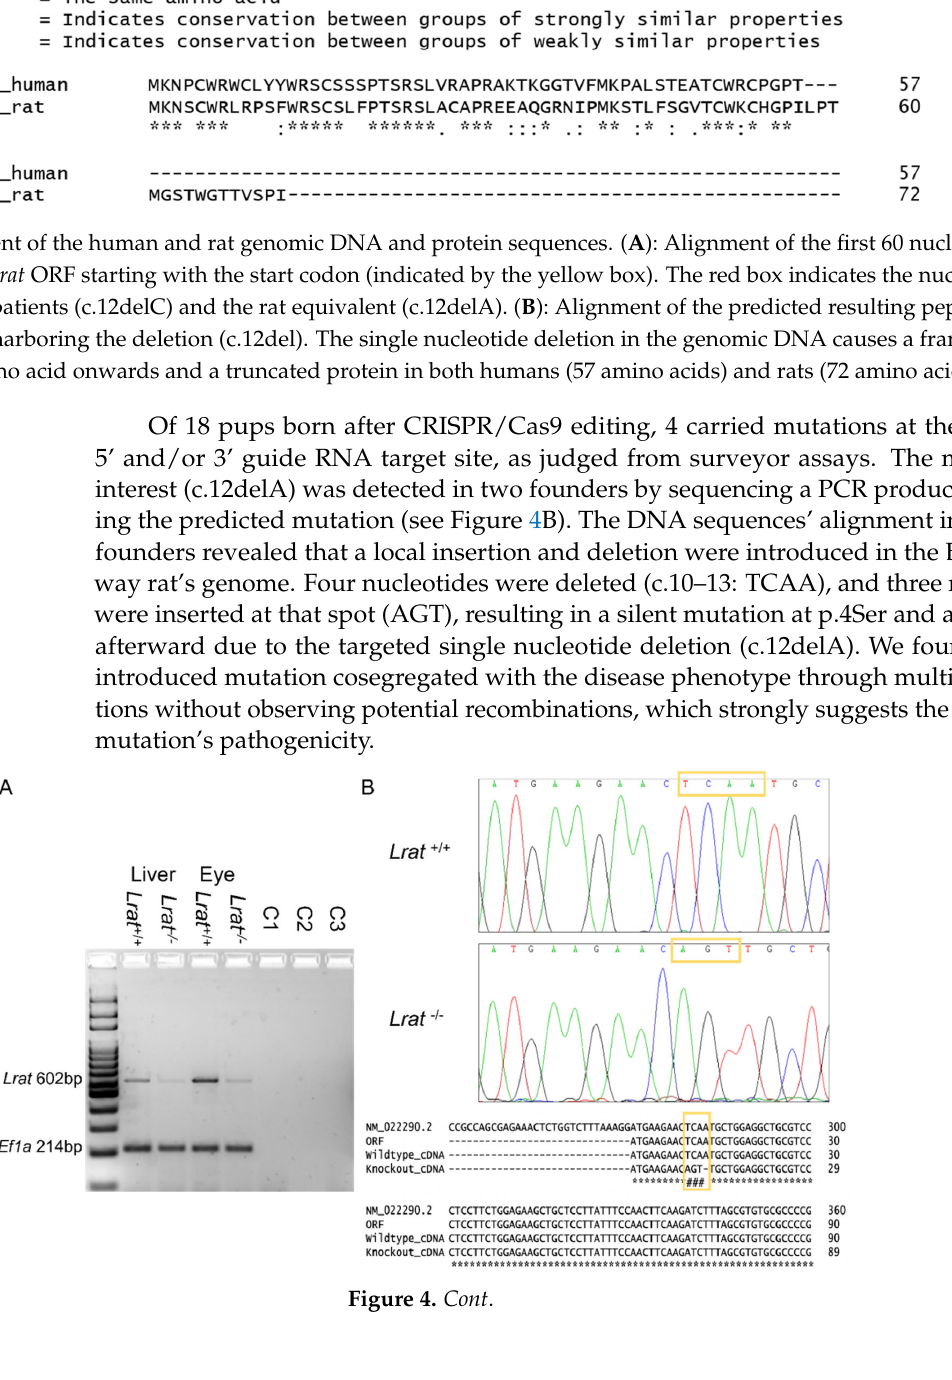
Figure 4. ( A ): mRNA expression of Lrat and Ef1a shown for Lrat +/+ and Lrat − / − animals for liver and eye tissues. Lrat expression was found in both wildtype liver and eye tissues. Significantly less RNA is found in Lrat − / − tissues. C1–3: Negative controls − / − cDNA in PCR reaction, − / − RNA in cDNA synthesis, and − / − SuperScriptIII in cDNA synthesis. ( B ): the presence of the introduced single nucleotide deletion and silent mutation in the Lrat mRNA of the Brown Norway rat was confirmed by Sanger sequencing. The rat reference sequence was retrieved from the NCBI database, Accession NM_02290.2. The open reading frame (ORF) of Lrat was determined using the ORFfinder (NCBI). ( C ): LRAT protein presence is confirmed in the liver of Lrat +/+ animals and (almost completely) absent in Lrat − / − liver tissue.